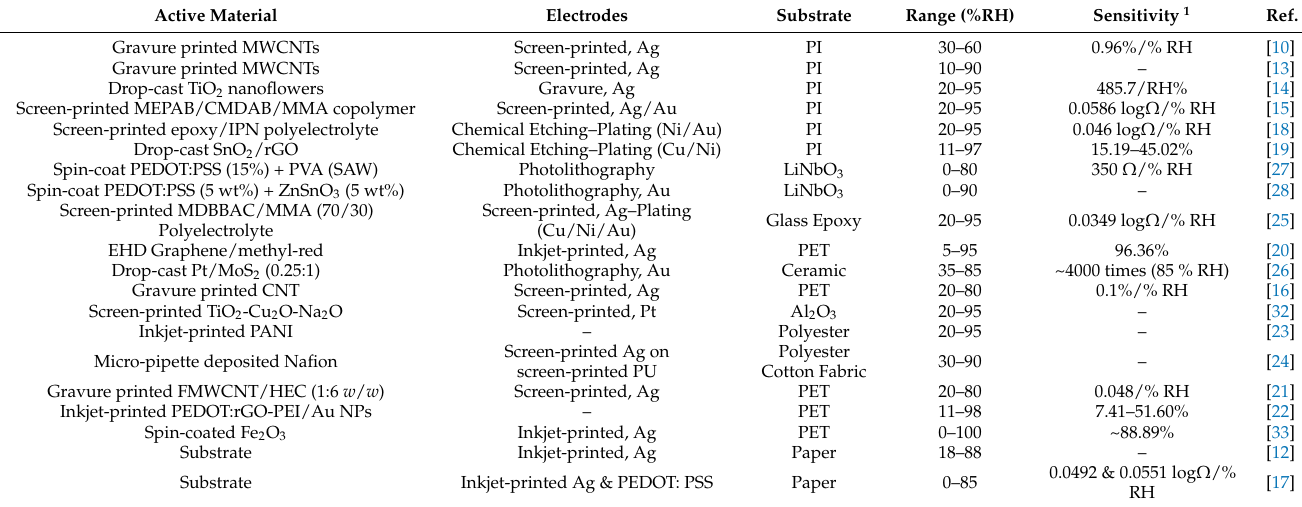
Table 2. Comparison of resistive humidity sensors.